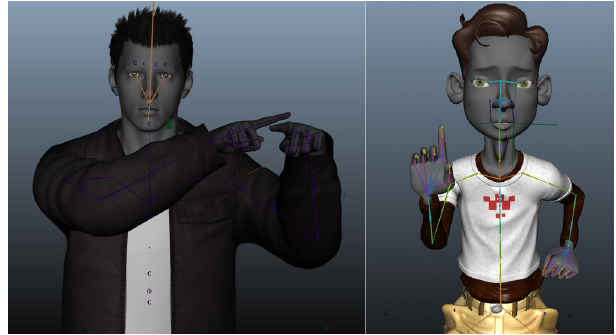
Figure 2. Tom, the realistic avatar (left); Jason, the stylized avatar (right). Models and skeletal systems.